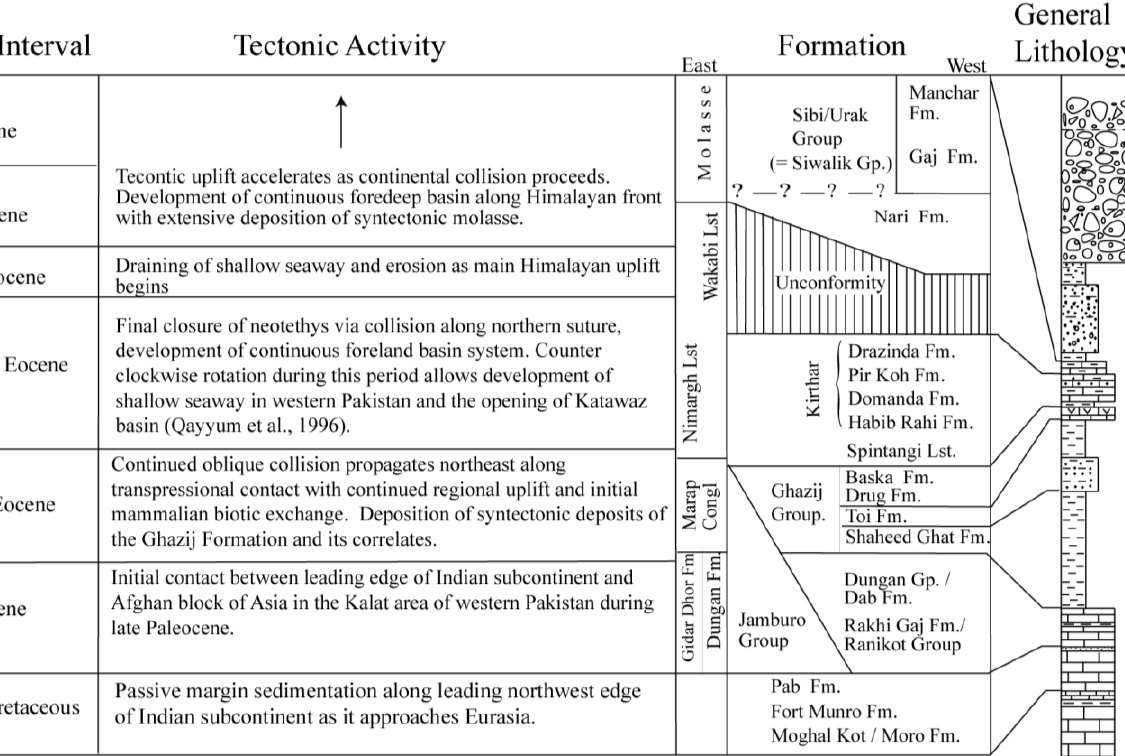
Figure 6. General time line showing the association between regional lithostratigraphic units and associated tectonic processes based on the favored interpretation of results presented